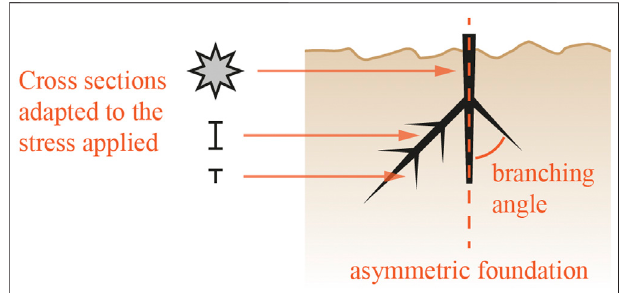
FIGURE 2 | Structural optimization concept based on root adaptation and machine learning — The design of a root-inspired foundation follows the root traits adapted to a speci fi c loading